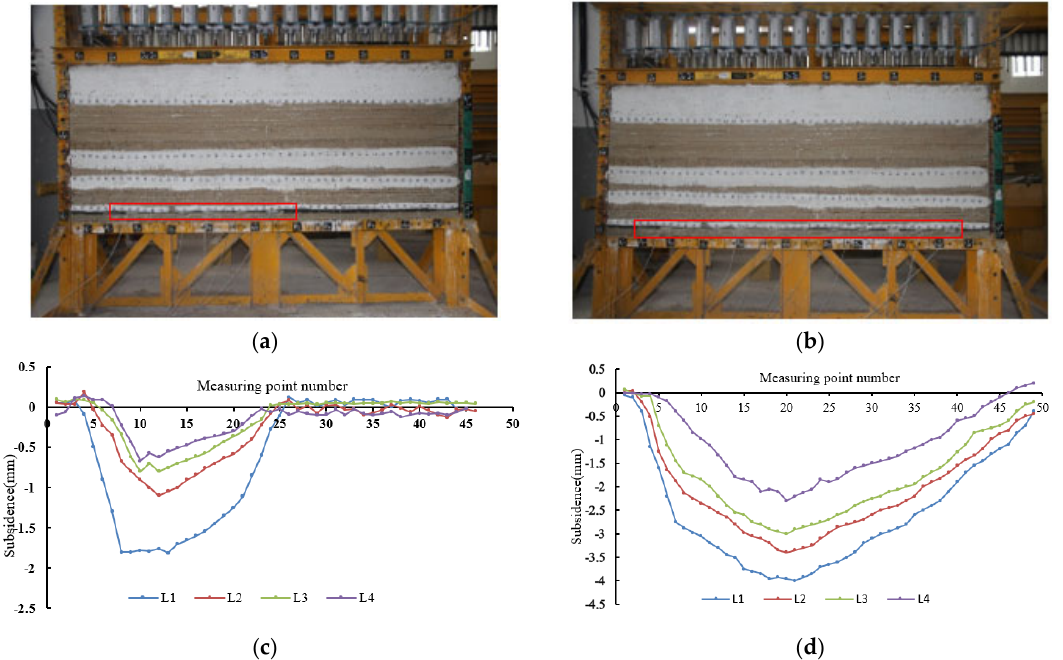
Figure 10. Overburden subsidence curves of 2 cm mining height physical model: ( a ) 102 cm mining width; ( b ) 204 cm mining width; ( c ) subsidence curves of 102 cm mining width; ( d ) subsidence curves of 204 cm mining width.